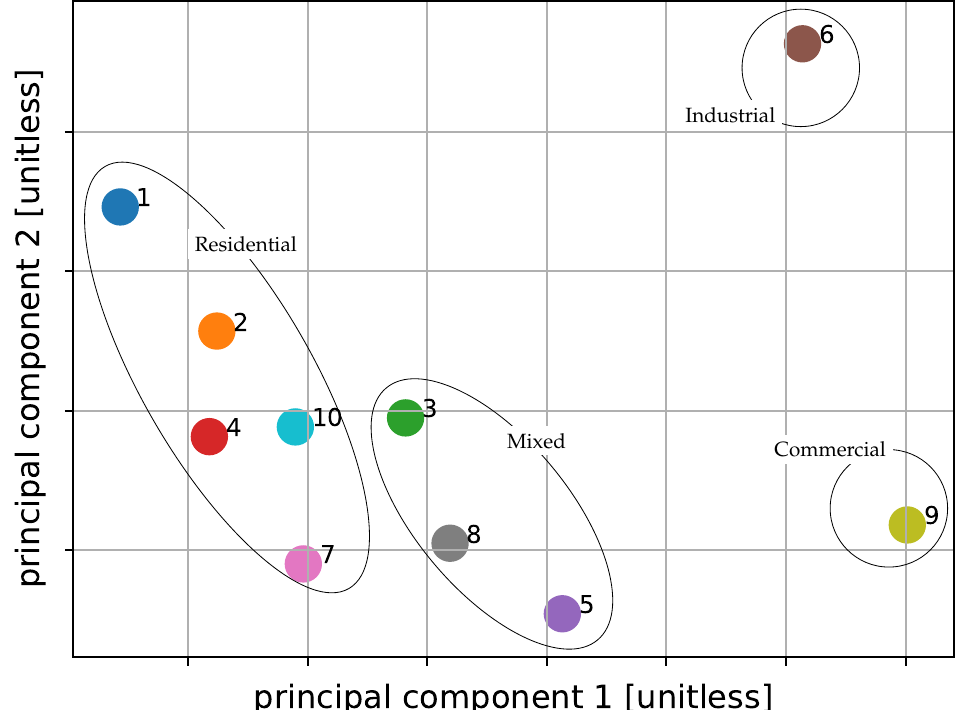
Figure 4. The classification of each feeder (indicated with the numerical label) depended on the the number and amount of demand for each load type. The K-means clustering algorithm grouped them into four categories. The first two principal components for each feeder provided a means to visualize the multidimensional data to describe the K-means algorithm